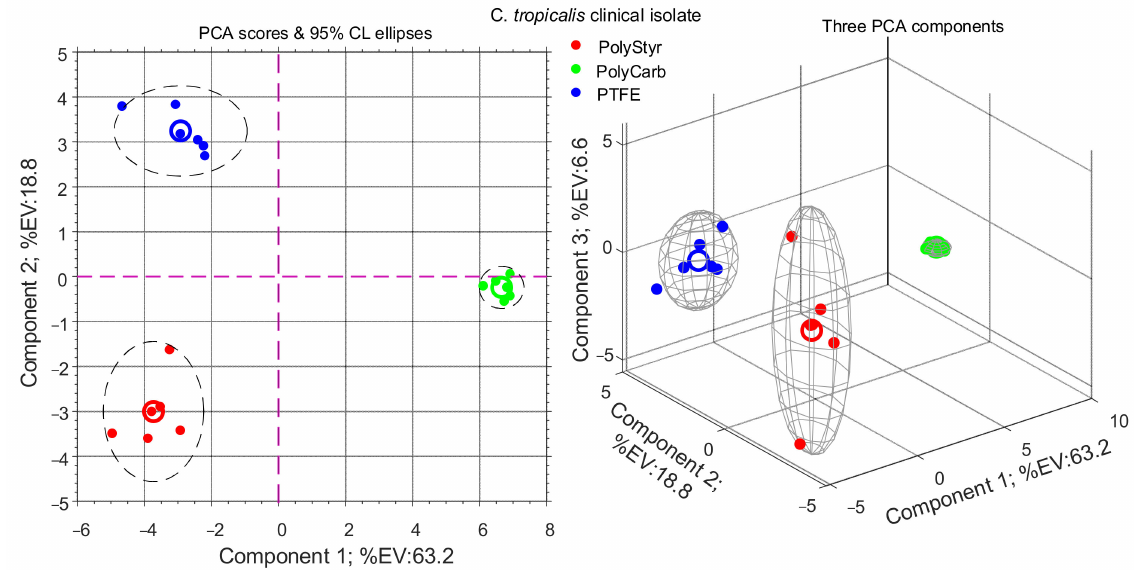
Figure 3. PCA analysis of intracellular metabolites extracted from cells of the clinical isolate of Candida tropicalis harvested from biofilms grown (72 h) on polystyrene (PolyStyr class), polycarbonate (PolyCarb class), and Teflon (PTFE